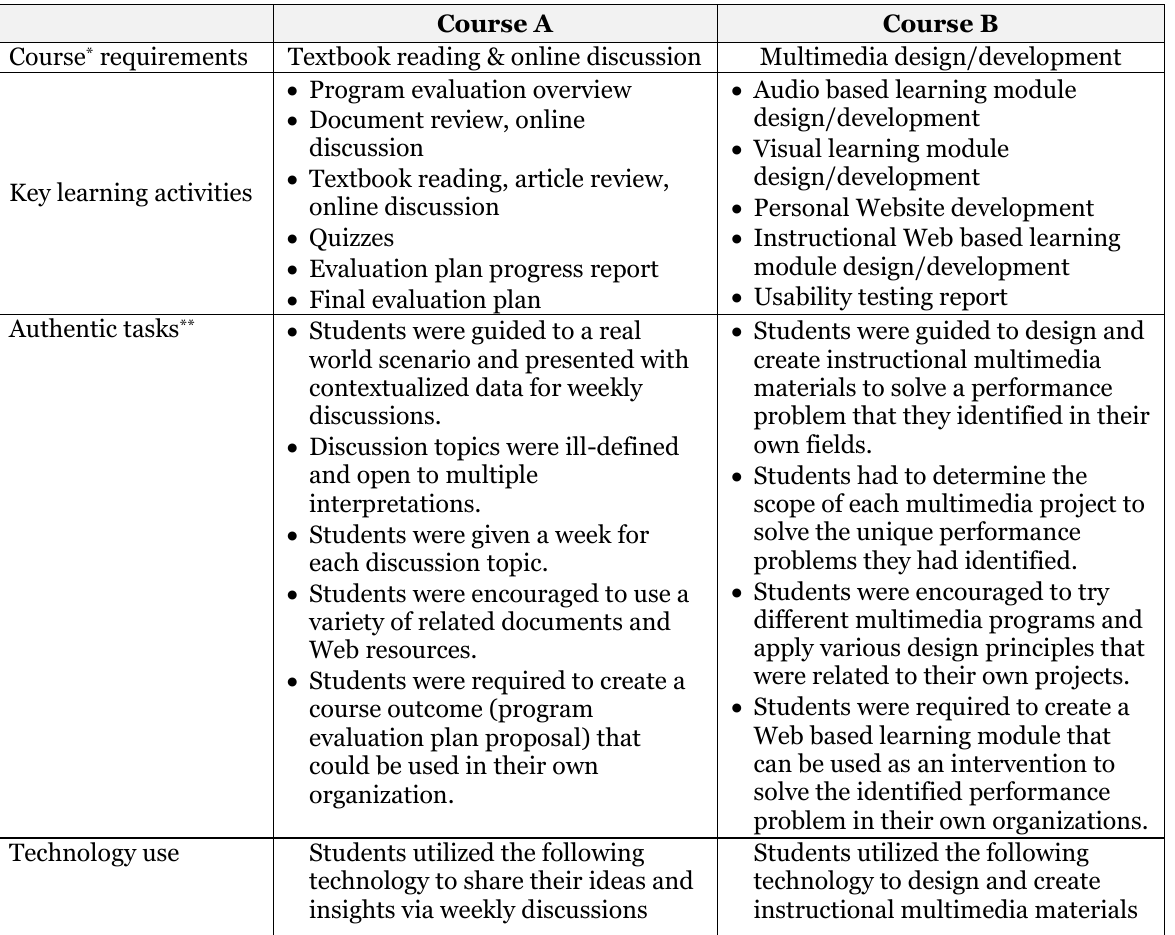
Comparison of Course Requirements, Key Learning Activities, Authentic Tasks, and Technology use Between